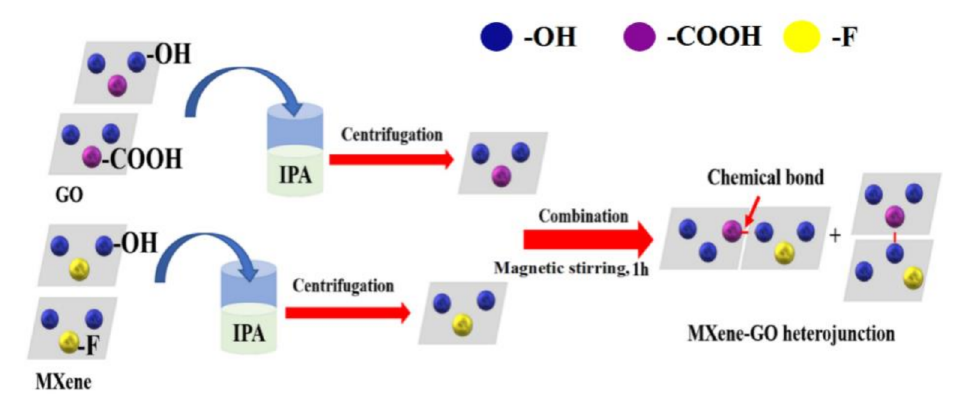
Figure 1. Illustration of the MXene–graphene oxide (MXene–GO) heterojunction preparation process.